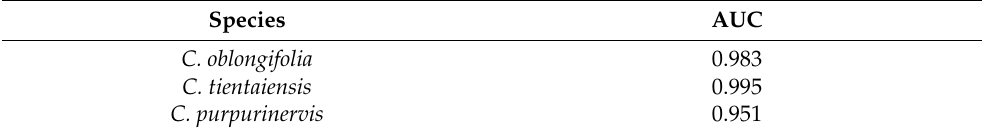
Table 2. AUCs under the current climate of three Carpinus spp. for mean values of 15 times